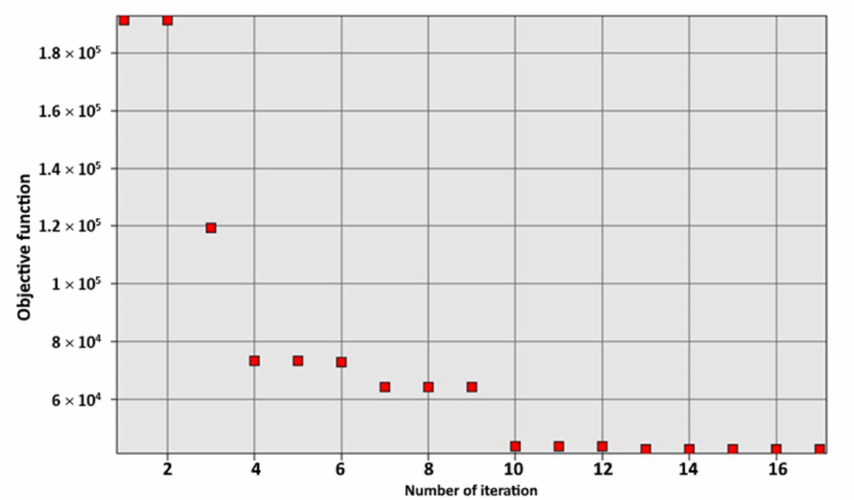
Figure 13. Results of the optimization procedure.